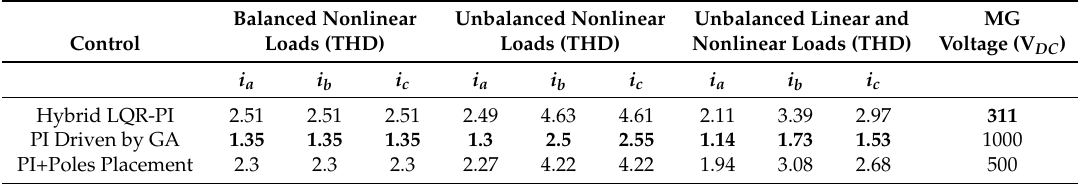
Table 9. Comparative analysis of THD and energetic cost obtained from the evaluated controllers.